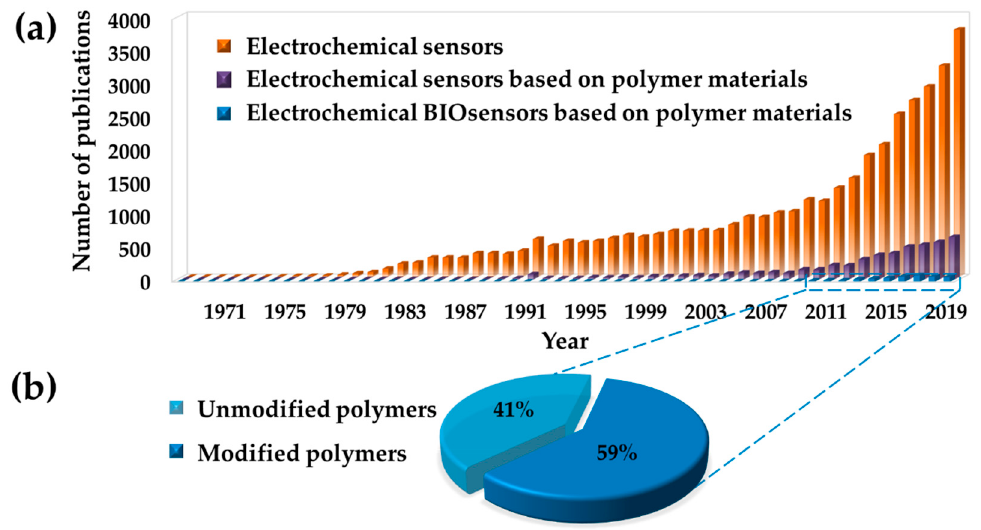
Figure 1. ( a ) Comparison between the evolution of electrochemical-based sensors published research papers per year in the last decade, based on polymer materials and employed in the biomedical field and ( b ) percentage of biosensors based on electrochemical detection composed made of unmodified and modified polymers. Source: Web of Science (WOS).